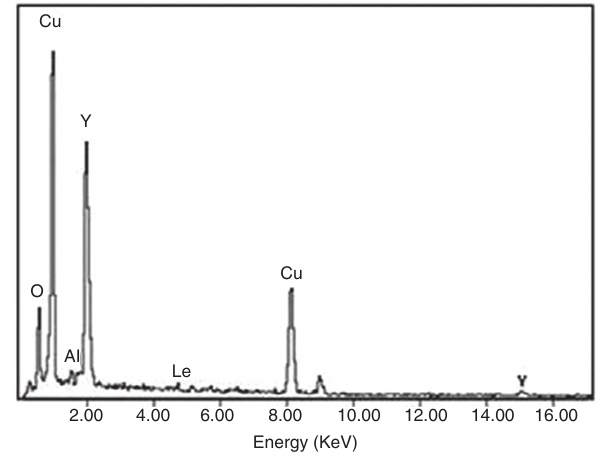
Figure 3 SEM microarea element analysis of the white spot in Figure